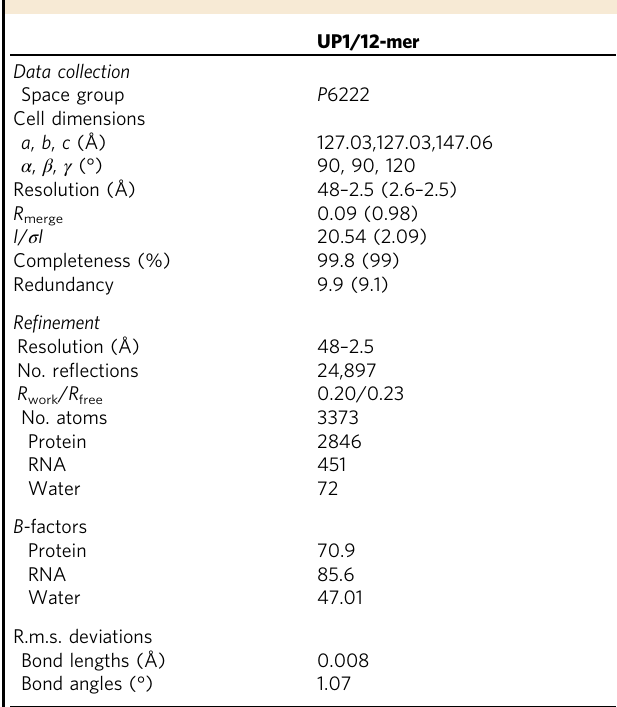
Table 2 Crystallographic data collection and re fi